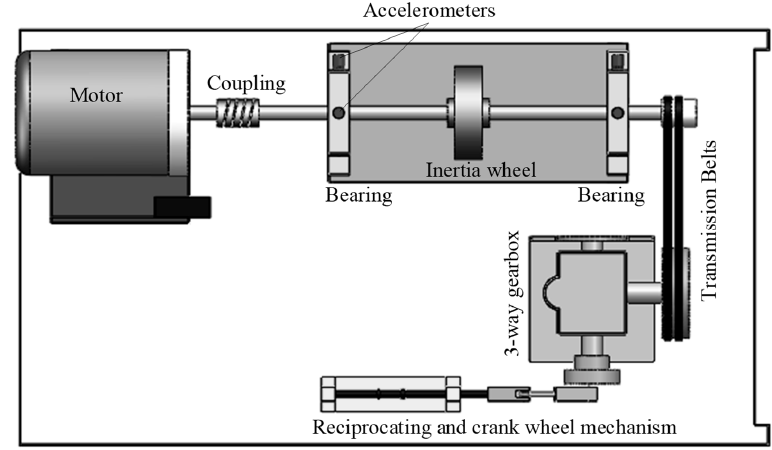
Figure 5. Machinery fault simulation bench.